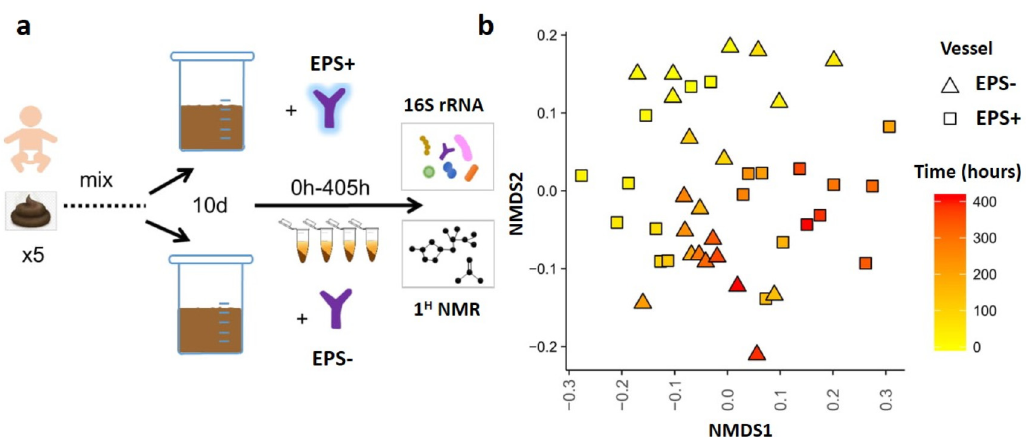
Figure 2. Experimental set-up and NMDS plots of EPS + and EPS − vessels. ( a ) Five di ff erent stool samples from four di ff erent infants, age 6–12 months, were combined, processed and added to each Vessel (see Methods). Vessels were acclimatized for ten days, followed by inoculation with, Vessel A: B. breve UCC2003 EPS + , and Vessel B: B. breve UCC2003del EPS − . Aseptic sampling was performed from 0–408 h after inoculation and processed for 16S rRNA analyses and NMR. Samples were taken before inoculation (t = 0), at time points (hours after inoculation) 6, 12, 24, 36 and from 48 h to 408 h every 24 h. ( b ) NMDS plot using a Bray–Curtis dissimilarity calculation, for both vessels and separately (Figure S2). Changes over time are coloured from yellow (time point 0 h) to red (time point 408 h).